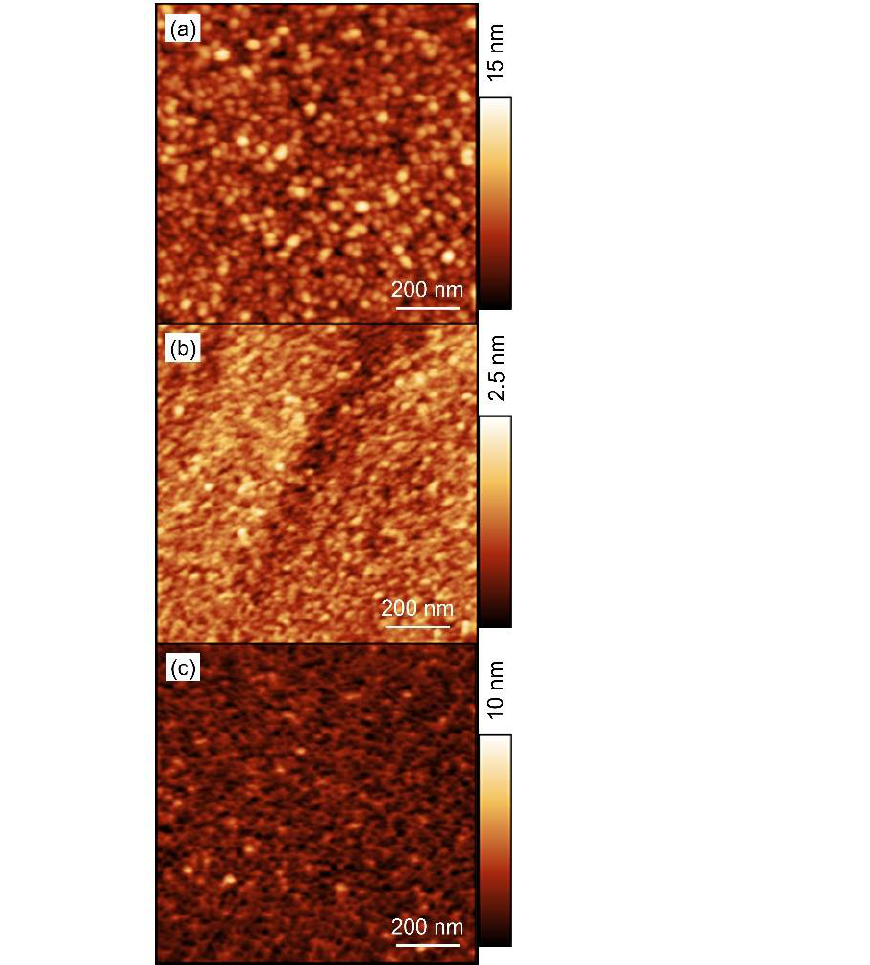
Figure 5. AFM micrographs of LT FME AlN samples: ( a ) A1, AlN grown with DMHy, ( b ) A2, AlN grown with NH 3 , and ( c ) A3, AlN grown on LT GaN with both layers grown with NH 3 . Scale bar at right goes from 0 nm to range given.